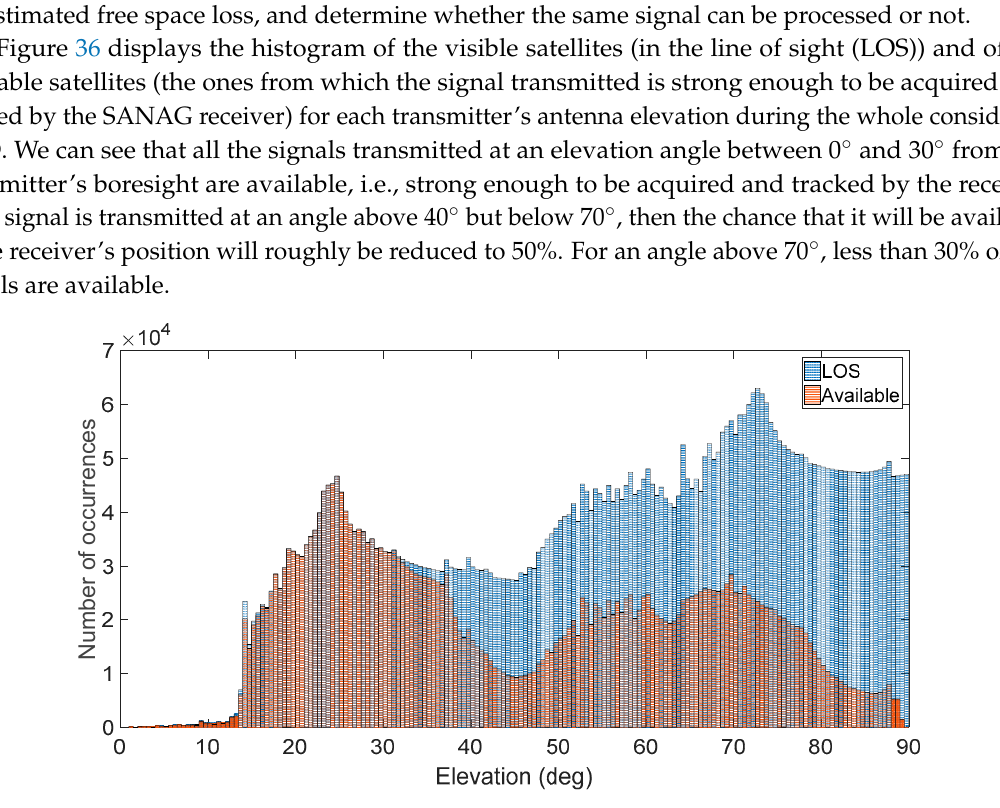
Figure 36. Histogram of the visible satellites (in the line of sight (LOS)) and of the available satellites (the ones from which the signal transmitted is strong enough to be acquired and tracked be the SANAG receiver) for each transmitter’s antenna elevation during the whole considered MTO.